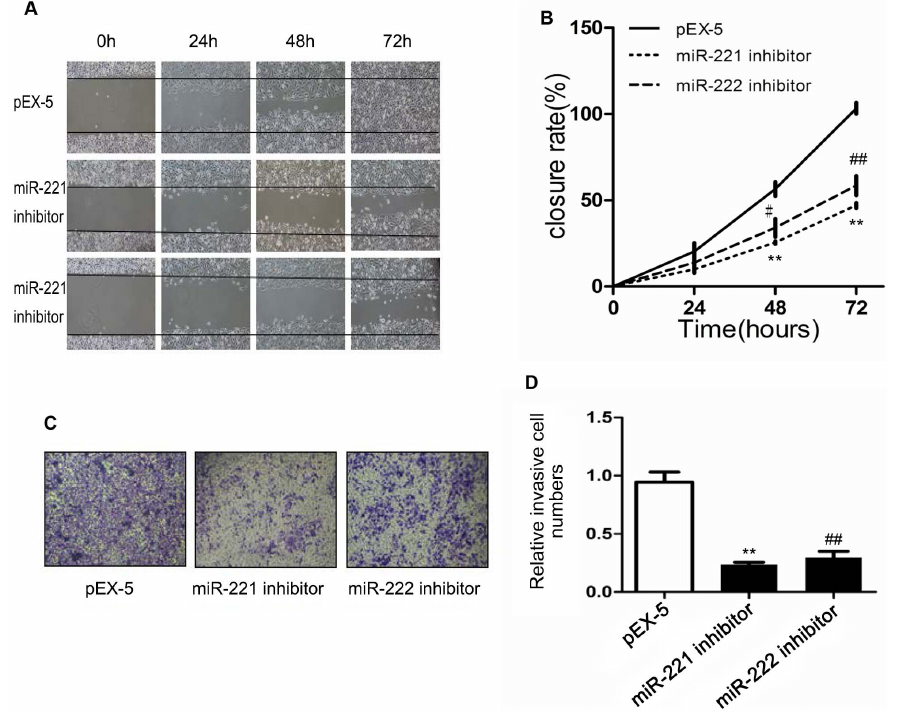
Figure 5. Effects of miR-221 inhibitor and miR-222 inhibitor on PC-3 cell migration. ( A ) Wound healing assay shows the closure rates of cells transfected with pEX-5 (empty vector plasmid), miR-221 inhibitor, or miR-222 inhibitor. ( B ) Quantitation of wound closure rates at different time points. ( C ) Transwell assay shows that the cells penetrated the insert membrane. ( D ) Quantitation of the n umber of cells that penetrated the insert membrane. Data represent the mean value 6 SEM from three separate experiments. *, # P , 0.05 vs pEX-5, **, ## P , 0.01 vs pEX-55).